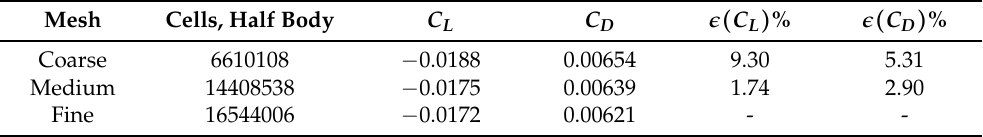
Table 2. Grid convergence study at α = 0 deg and AoA = 0 deg. Mesh Cells, Half Body